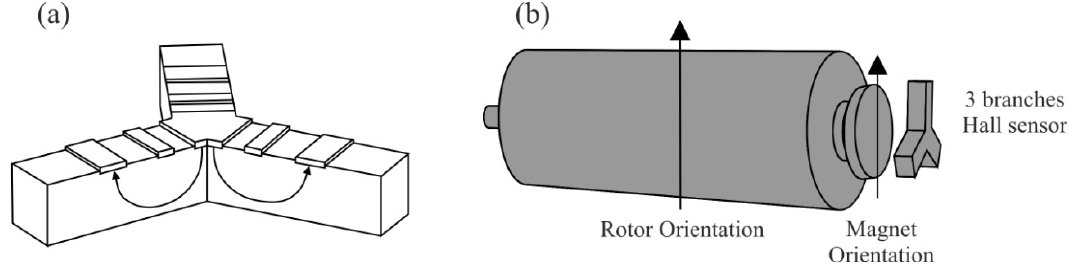
Figure 2. (a) Schematic representation of a three branches Hall sensor. (b) Three branches vertical Hall device mounted as angular position sensor for brushless motor control [11].